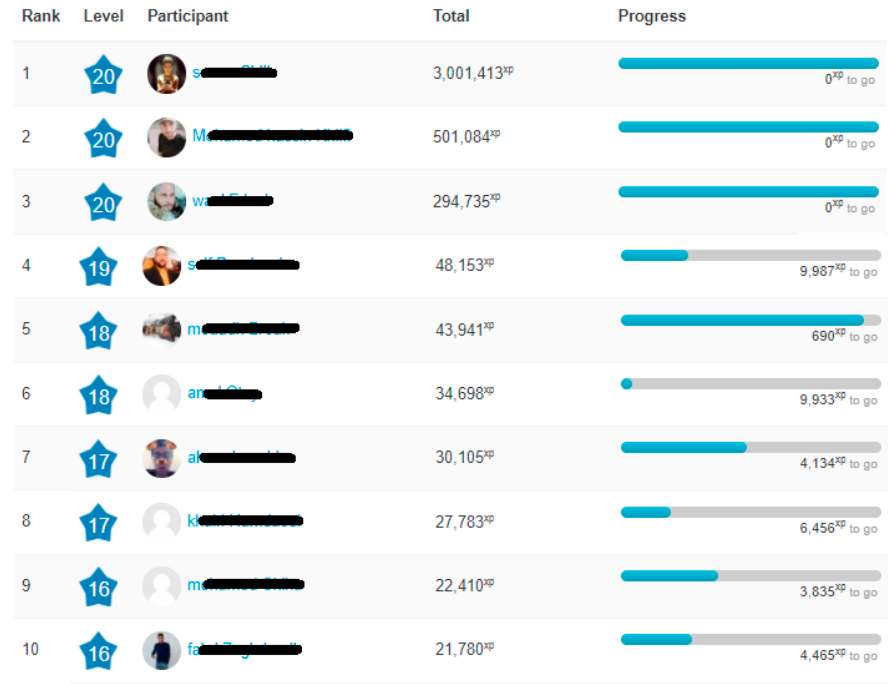
Figure 3. Leaderboard of the OODM course.